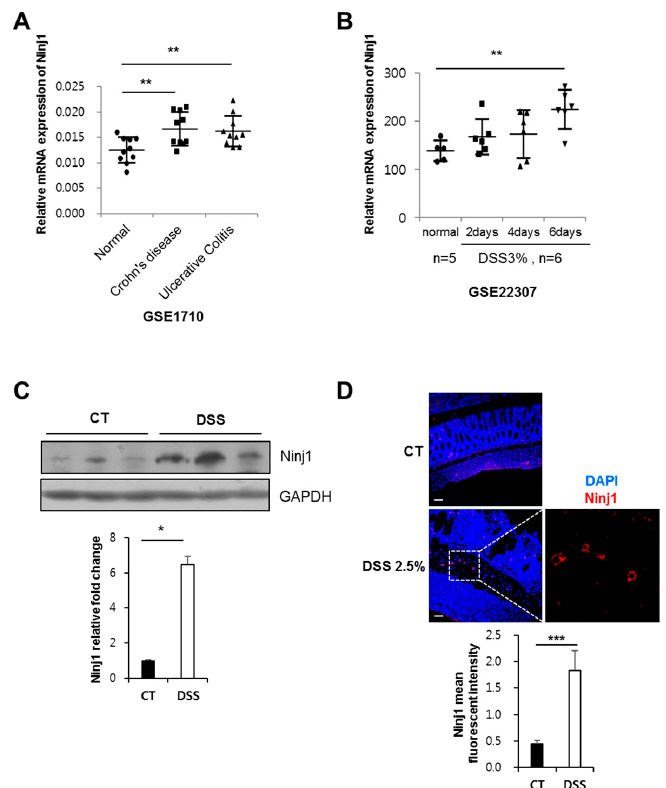
Figure 1. Nerve injury-induced protein 1 (Ninj1) expression in colon during experimental colitis. ( A ) Analysis of Ninj1 expression in colon tissues from ulcerative colitis (UC) and Crohn’s disease (CD) patients. The gene expression data (GSE1710) were obtained from the GEO database. ** p < 0.01, Welch’s T test. ( B ) Analysis of Ninj1 expression in colon tissues from mice. The gene expression data (GSE22307) were obtained from the GEO database. ** p < 0.01, Welch’s T test. ( C ) Immunoblot analysis of Ninj1 and GAPDH performed on colonic tissues extracted from control (CT) and 1.5% DSS-treated mice; n = 3 per group. Similar results were observed in three independent experiments. Densitometry represents relative protein levels of Ninj1. Values are mean ± SD. * p < 0.05, Student’s t -test. ( D ) Immunofluorescence staining of Ninj1 in colon tissue sections harvested from mice. Representative images are shown. Scale bars, 50 μ m. Boxed area is magnified on right. The quantification of Ninj1 immunofluorescence is presented as the mean fluorescence intensity; n = 3 per group. Values are mean ± SD. *** p < 0.005, Student’s t -test.